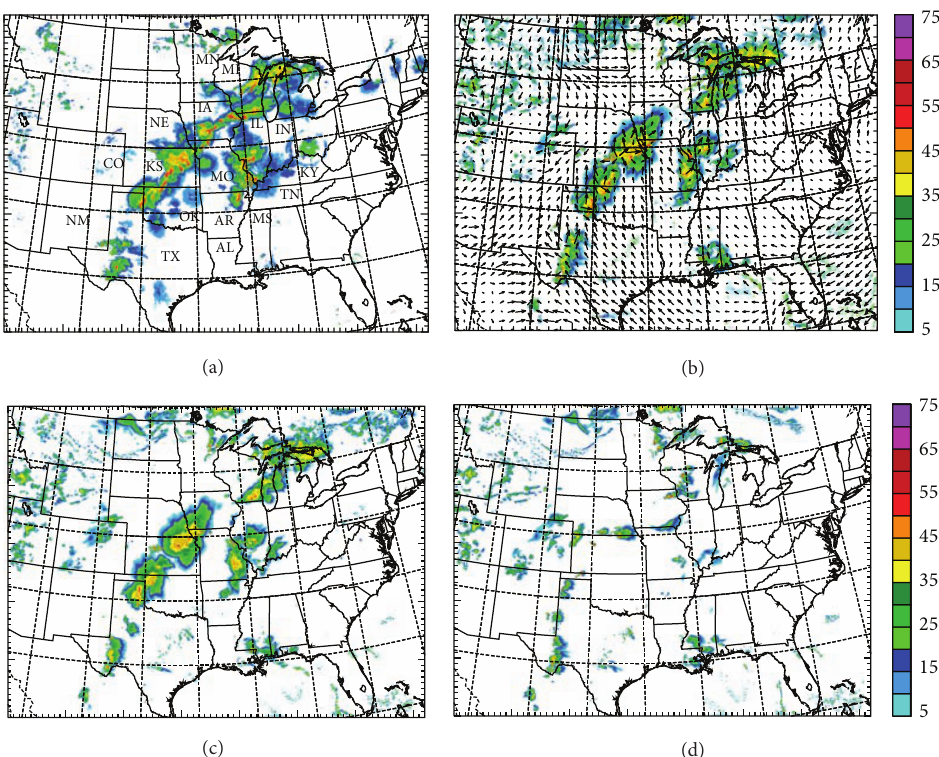
Figure 1: Observed composite radar reflectivity at 0300 UTC, May 26, 2008 (a) and 3-hour forecasts of the same field valid at the same time from (b) the 1km forecast with radar data assimilation, (c) 4 km control forecast with radar data assimilation, and (d) 4km forecast without radar data. Panel (b) includes surface wind vectors at 10m AGL plotted at every 80th grid